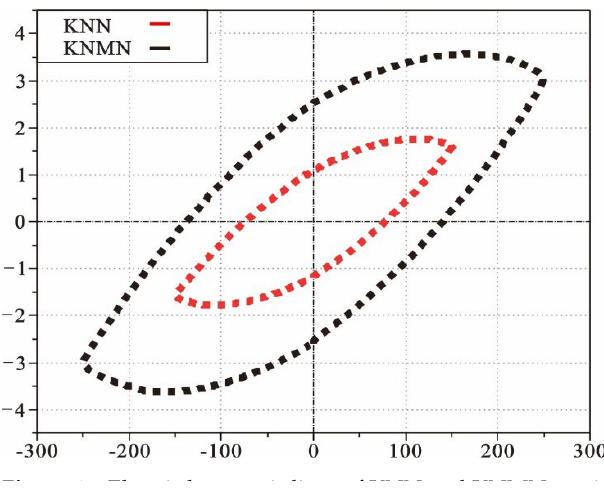
Figure 12. Electric hysteresis lines of KNN and KNMN